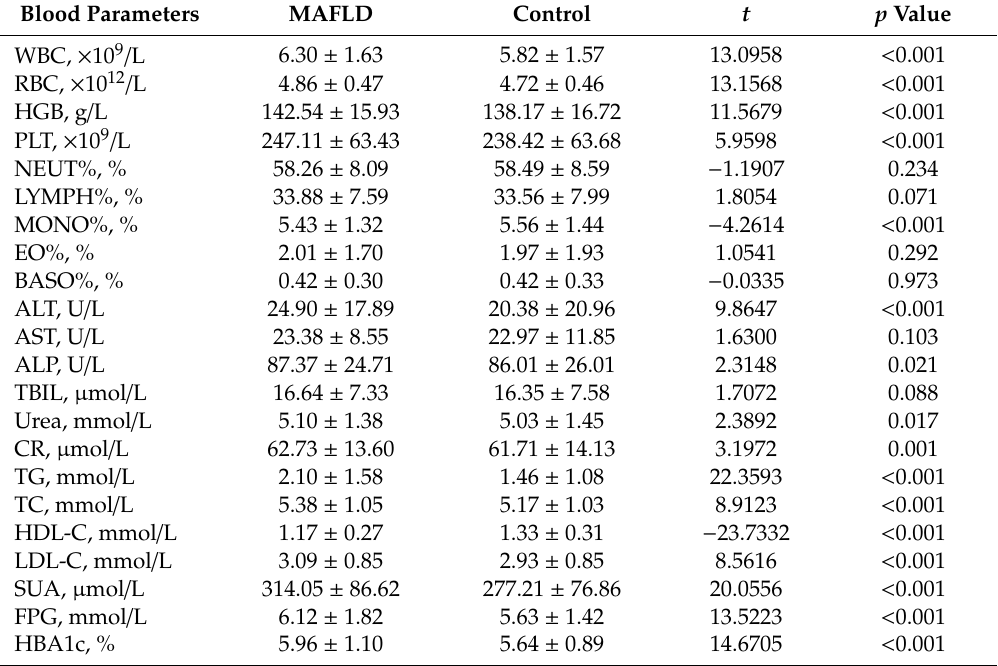
Table 3. Comparison of the blood biochemical parameters between the participants with and without MAFLD.